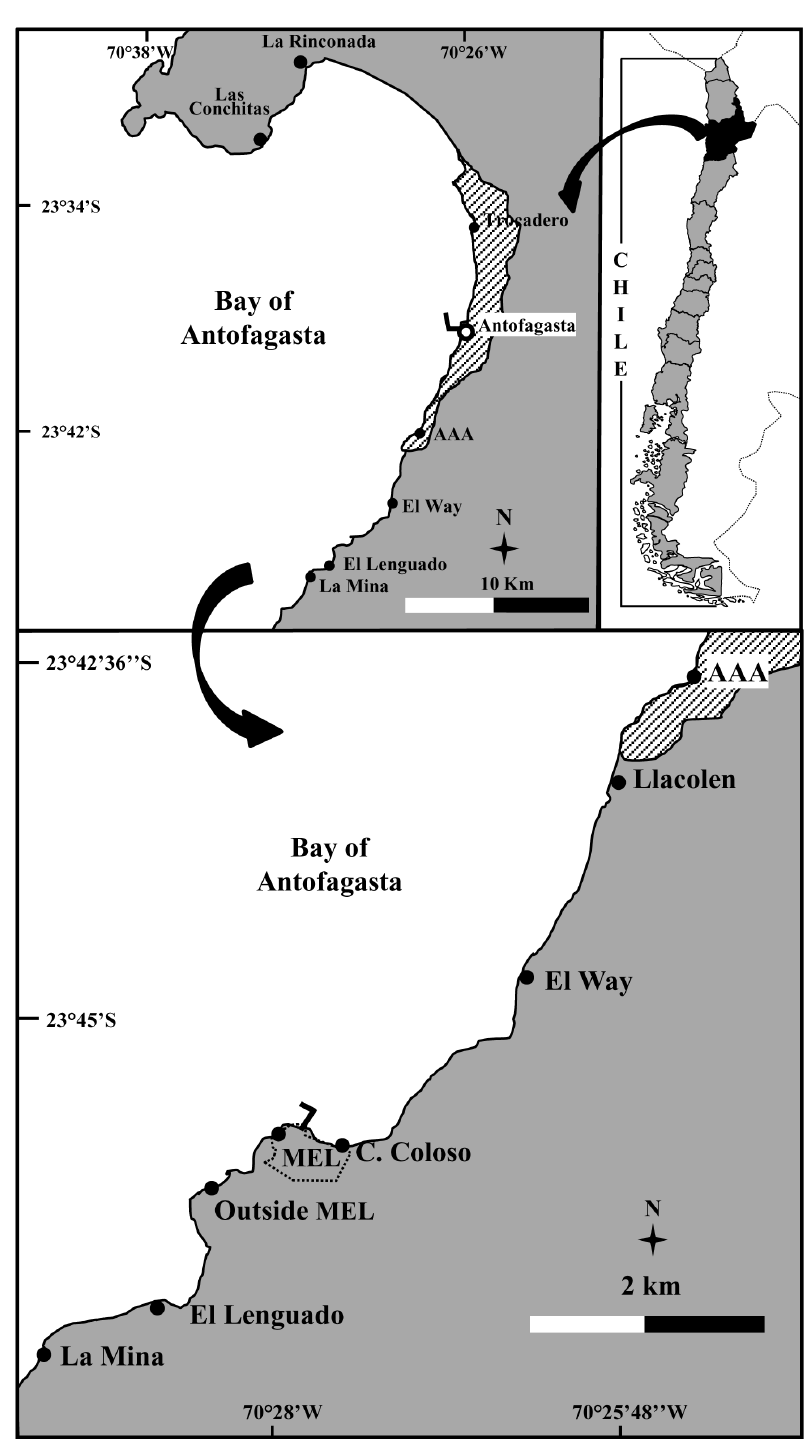
Figure 1. Map of the Bay of Antofagasta depicting the working area and main locations (see further details in reference 37). doi:10.1371/journal.pone.0110301.g001 possible mechanistic (cause-effect) interactions among such impacts along with complexes of species.